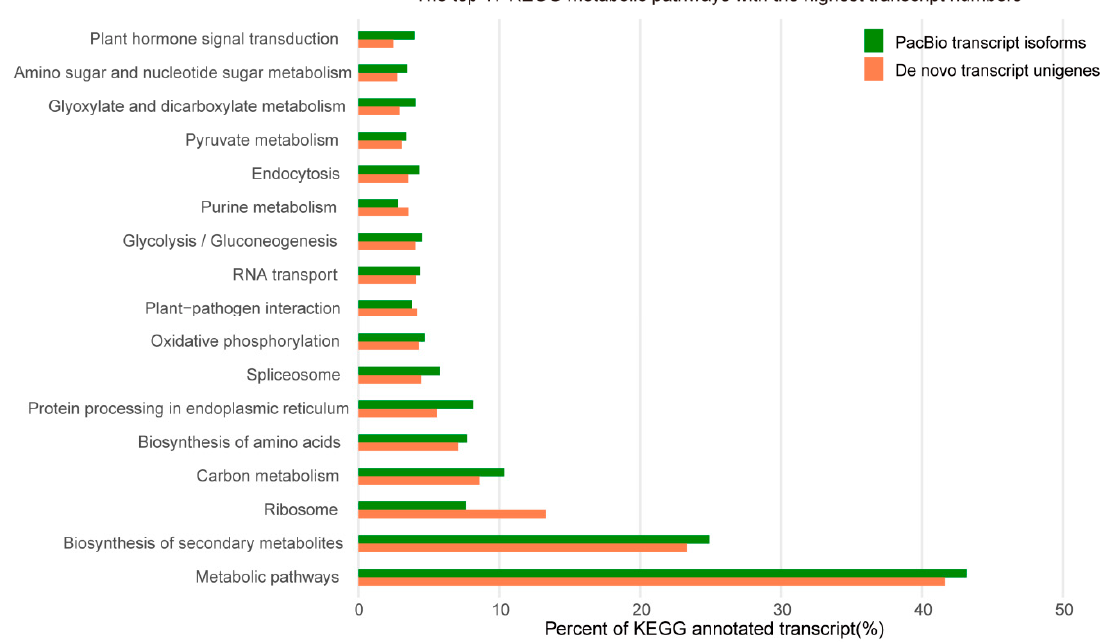
Figure 10. KEGG metabolic pathway classification of M. pasquieri PacBio transcript isoforms and de novo transcript unigenes.